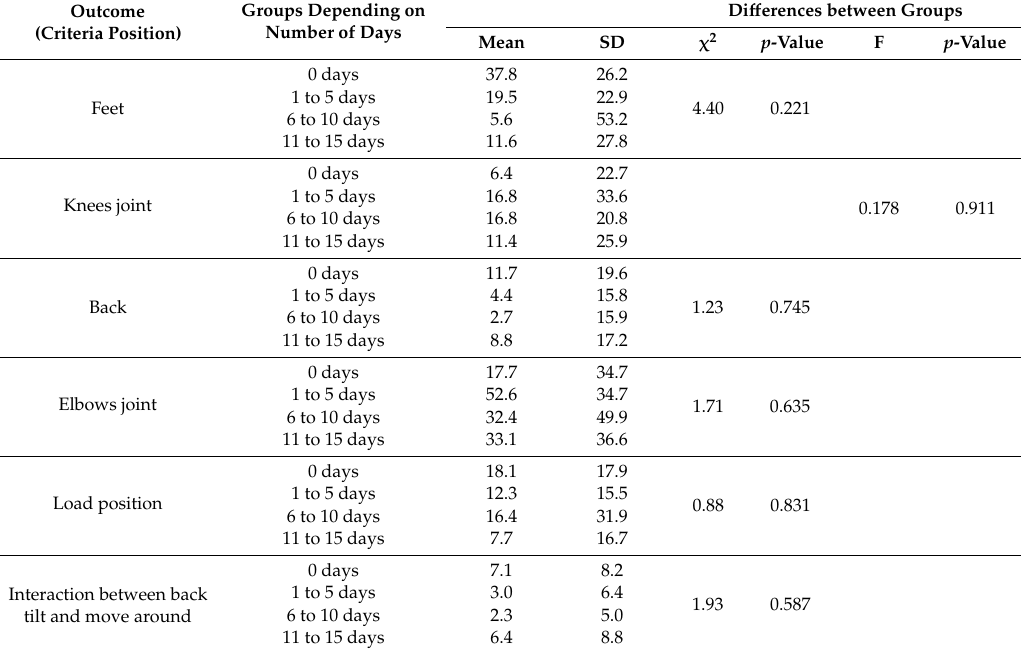
Table A3. Di ff erences in the score change (pre-post) of the relative duration in which each criterion was in the recommended position by the SsObserWork group according to the number of days the self-report questionnaire was